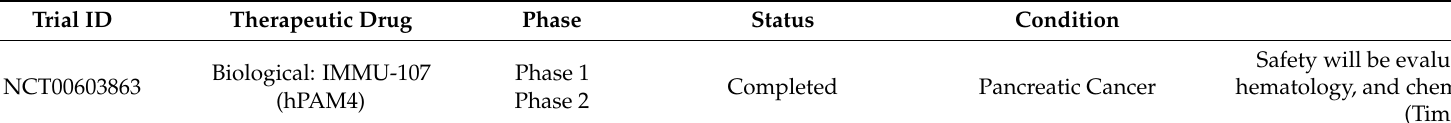
Table 4. Recent clinical trials based on immunotherapy in human pancreatic